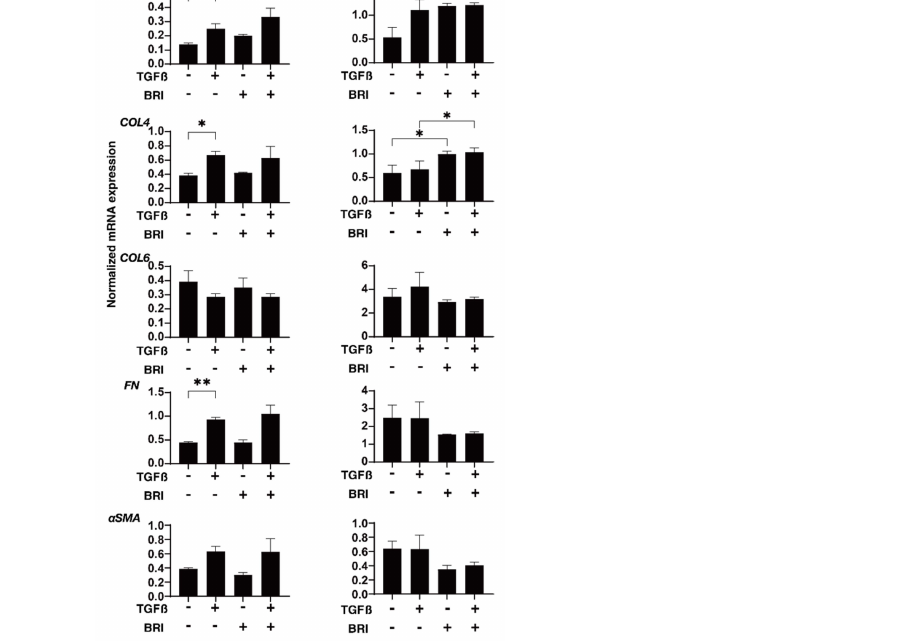
Figure 4. Effects of brimonidine (BRI) on the gene expression of ECM molecules in TGF- β 2-treated 2D and 3D HTM cells.The 2D- and 3D-cultured HTM on day 6 were untreated (NT) or treated with 5 ng/mL TGF- β 2 (TGF β ) in the presence or absence of 10 µ M brimonidine (BRI) and were applied to a qPCR analysis to evaluate the mRNA expression of ECMs, including COL1 4 and 6 , FN , and a-SMA . “+” is reagents addition. “ − ” is reagents non-addition. All analyses were conducted in triplicate using freshly prepared 2D cells ( n = 5) and 3D spheroids ( n = 15–20) in each experiment. Regarding the data, the mean ± standard error of the mean (SEM) are shown. * p < 0.05, ** p < 0.01; ANOVA followed by a Tukey’s multiple comparison